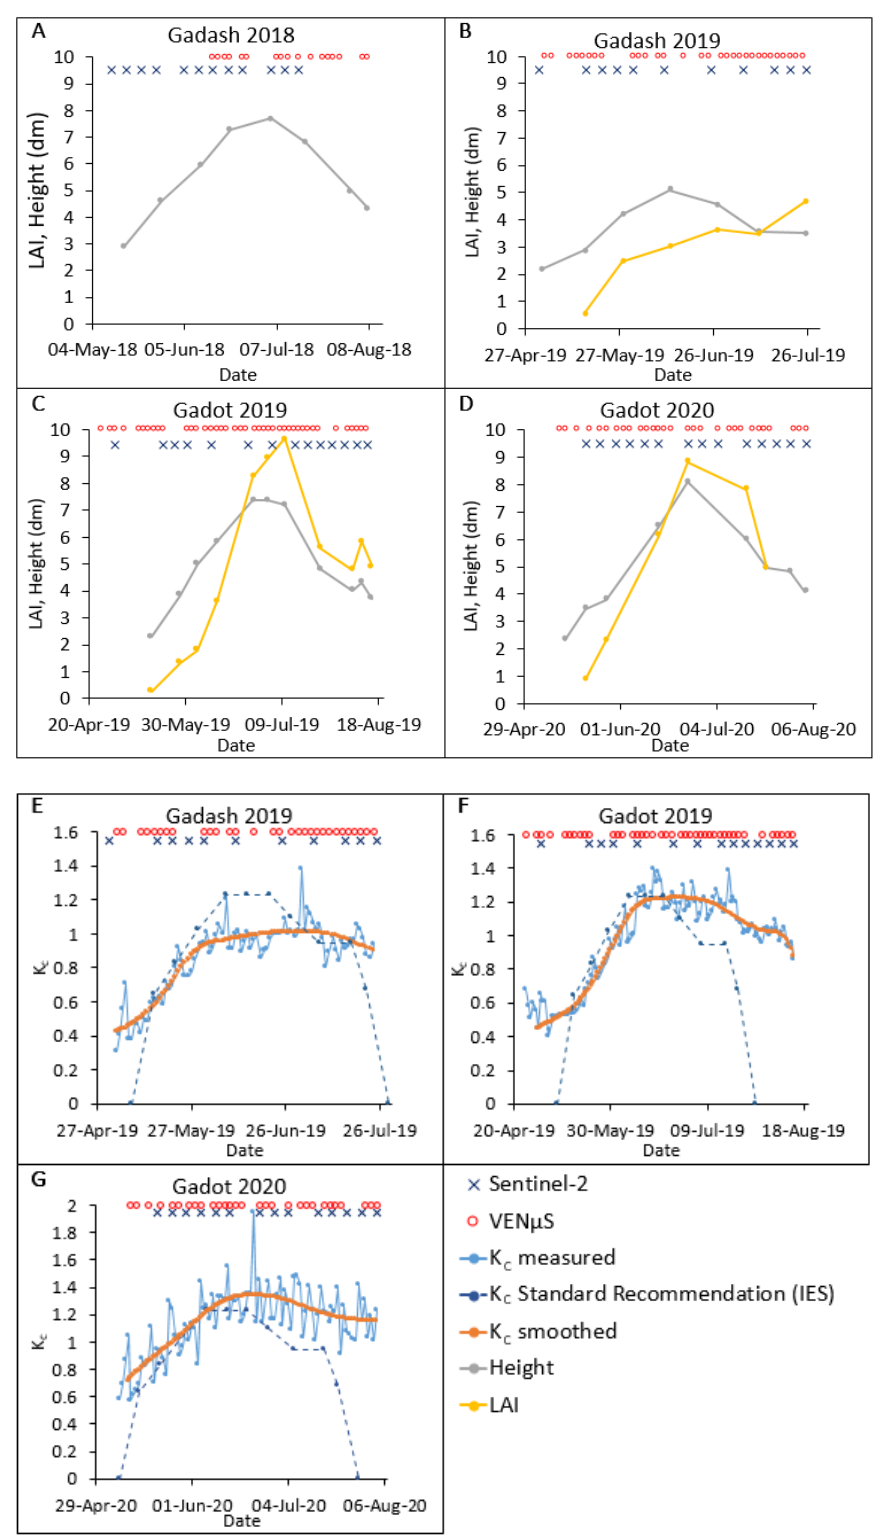
Figure 2. Processing tomato experiments data: measured height, measured LAI, and